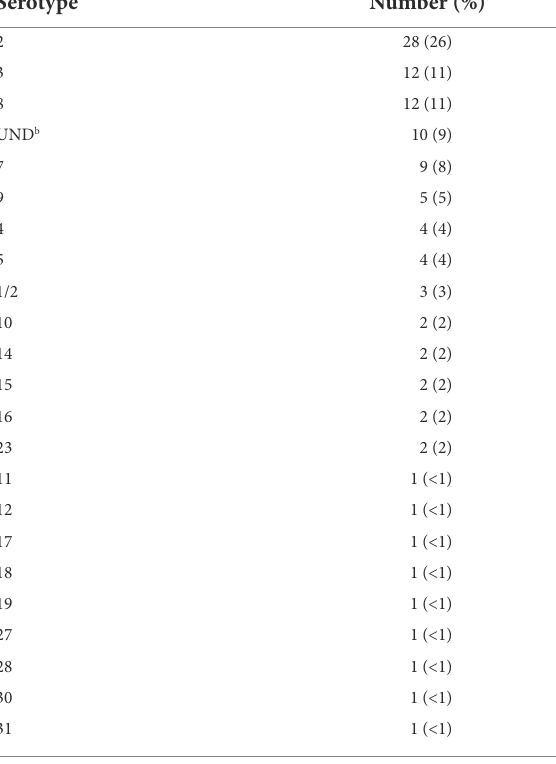
TABLE 3 Phenotypic AMR prevalence among S. suis isolates.